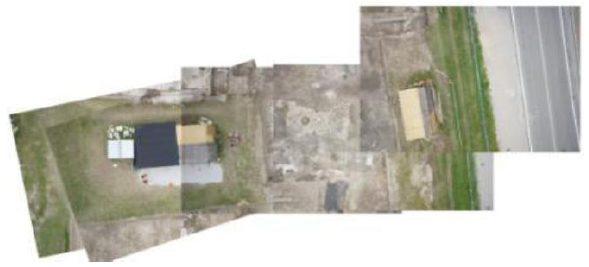
Figure 6. Set of images of the photogrammetric block acquired on the Domus.